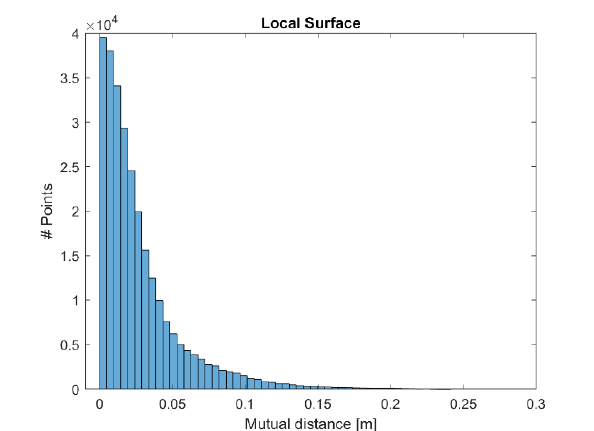
Figure 15. Distance histogram for global surface strategy.